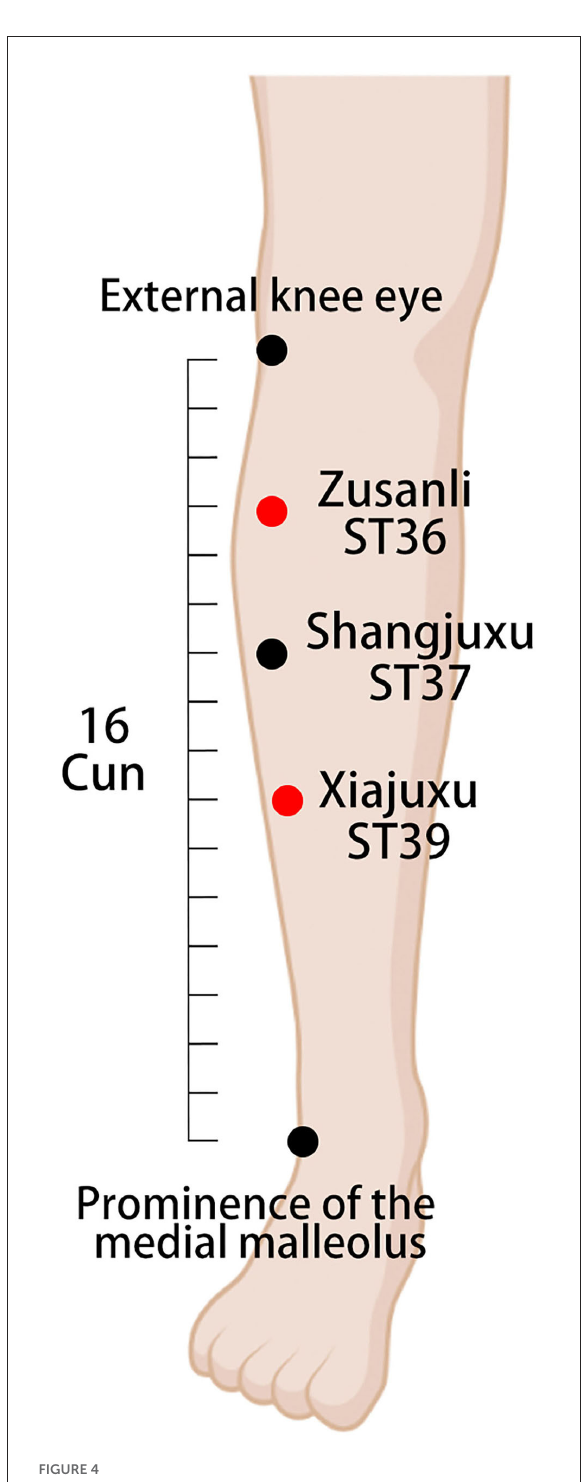
FIGURE4 Location of lower extremity acupoints and electrode connection. ST36 (Zusanli) on the lateral lower leg, 3 cun under the external knee eye. ST37 (Shangjuxu) on the lateral lower leg, 6 cun under the external knee eye and 3 cun under the ST36 (Zusanli) acupoint. ST39 (Xiajuxu) on the lateral lower leg, 9 cun under the external knee eye. A set of electrodes is attached at the red dot